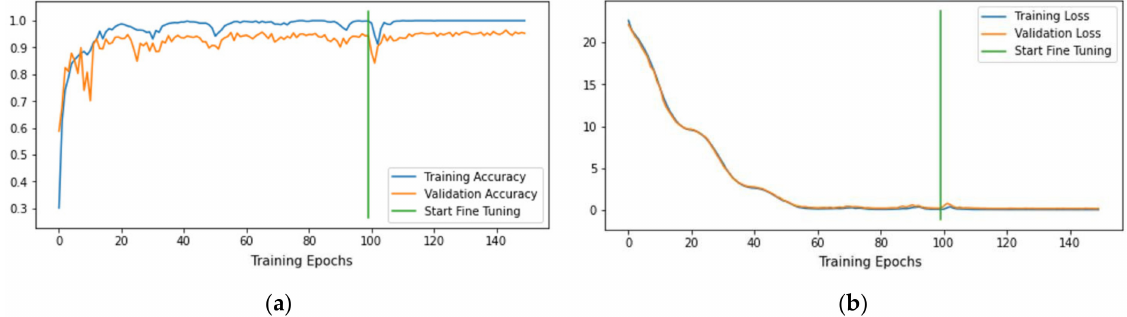
Figure 11. Model training history of RSSCN7 dataset: ( a ) training and validation accuracy; ( b ) training and validation loss.